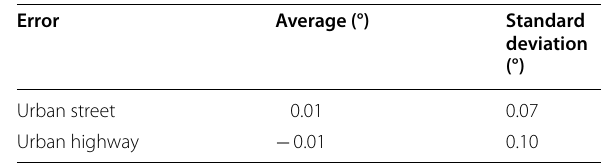
Table 4 Error of estimated slip